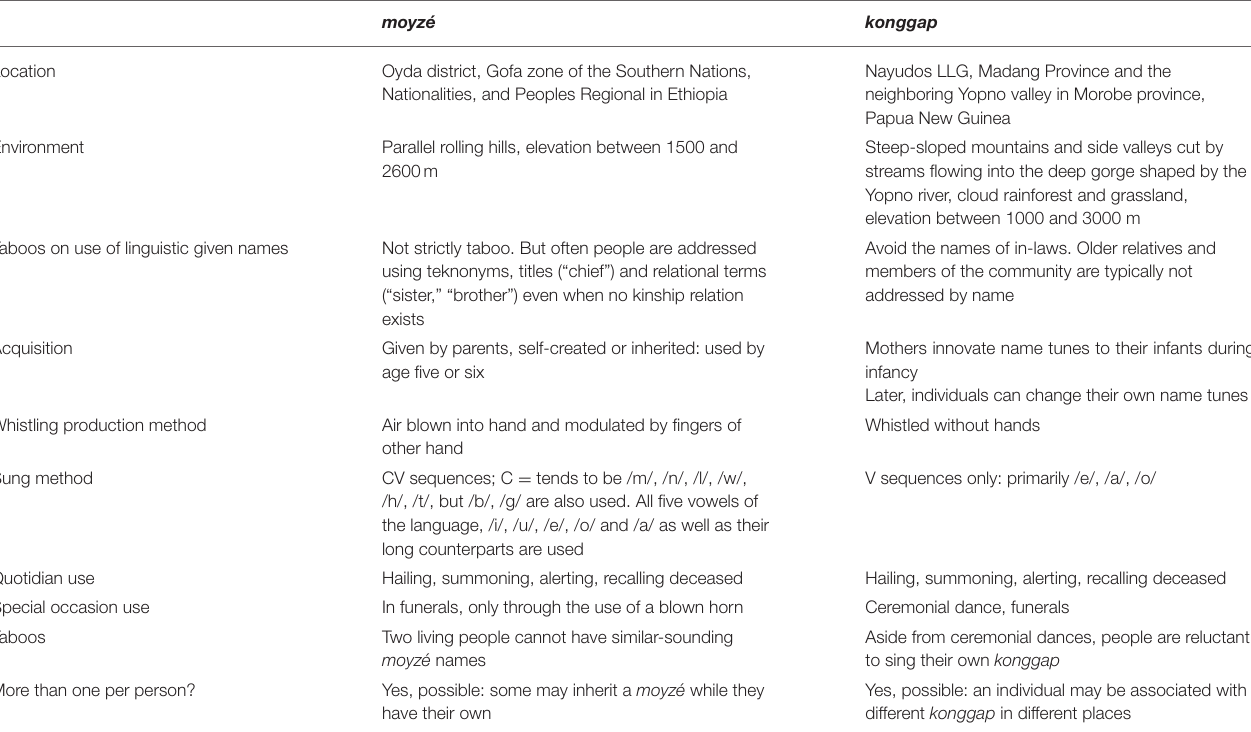
TABLE 1 | Comparative summary, moyzé , and konggap